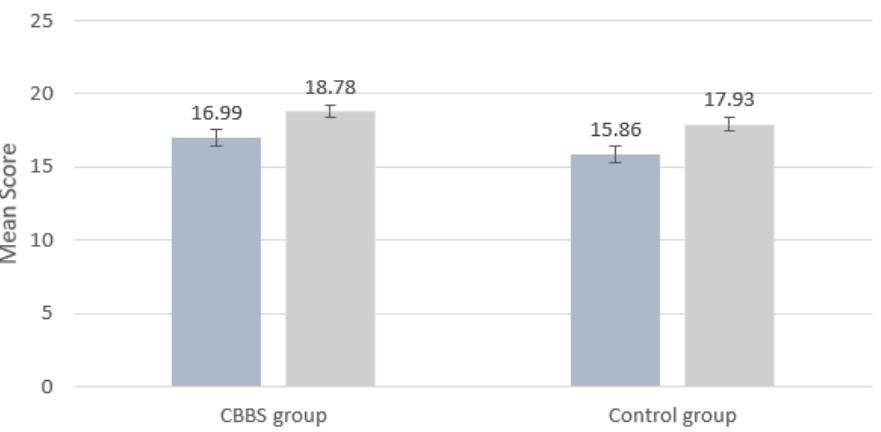
Figure 7. Mean scores of PACER test at the pre-test and post-test by group.